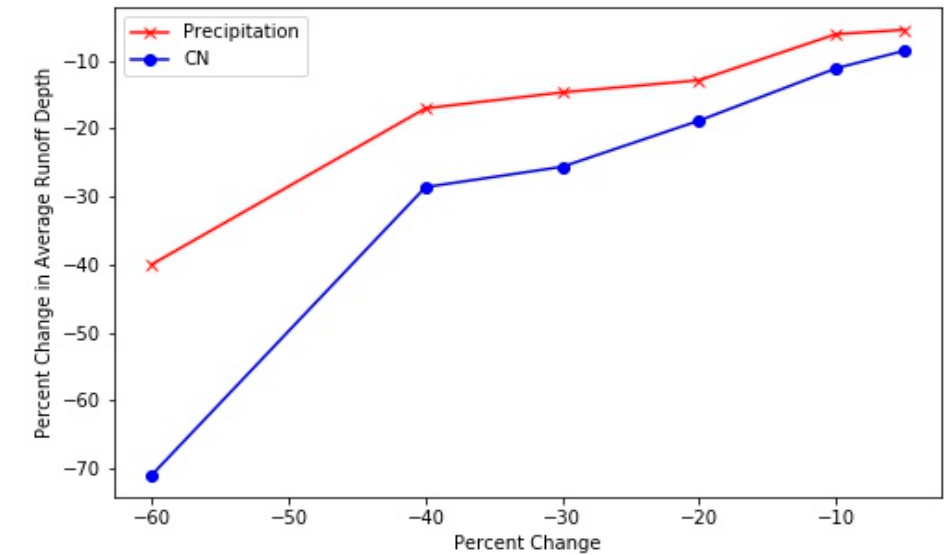
Figure 11. Sensitivity of the developed NRCS model relative to CN and precipitation.